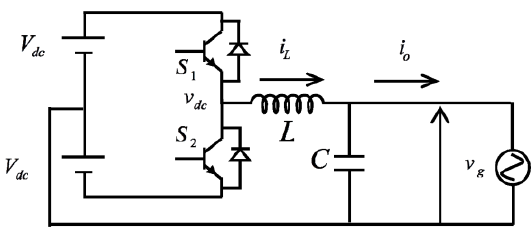
Figure 1. Single-phase half-bridge inverter circuit.